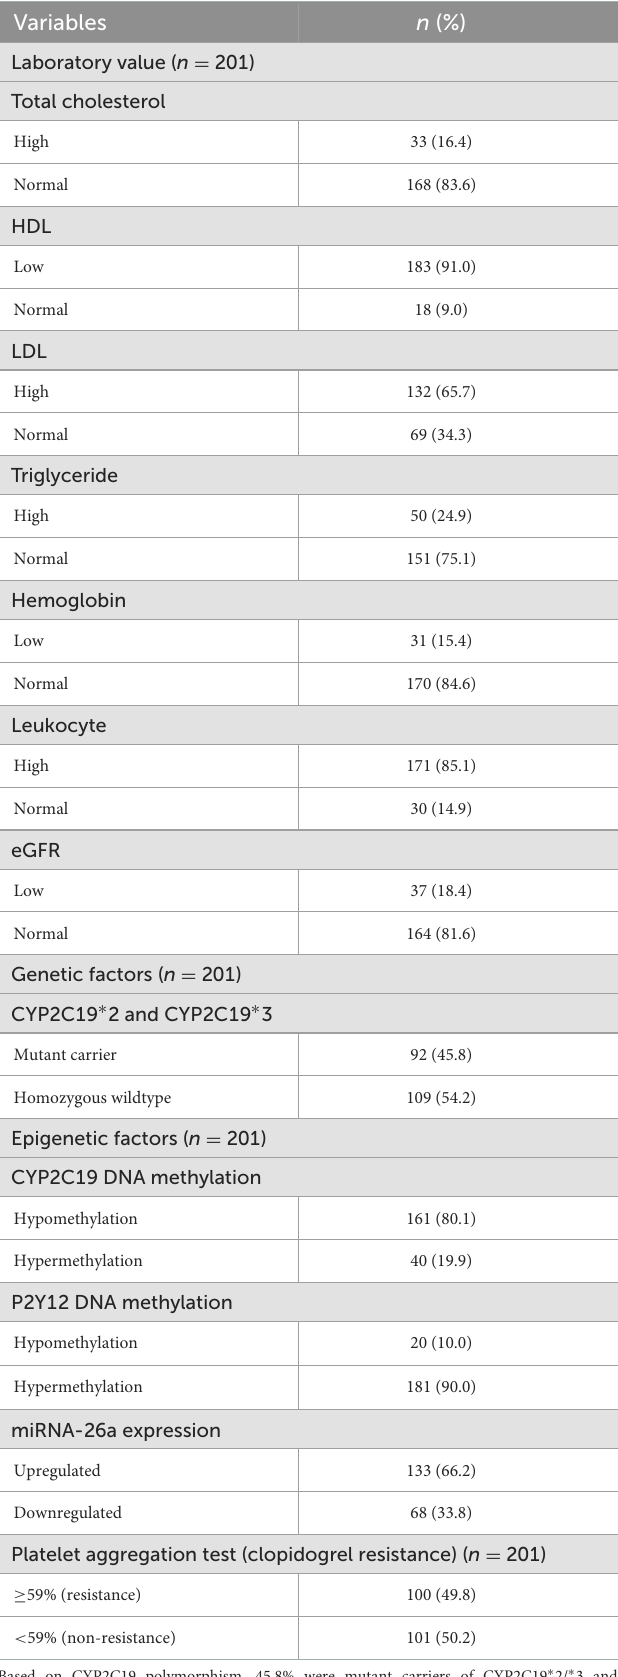
TABLE 3 Laboratory